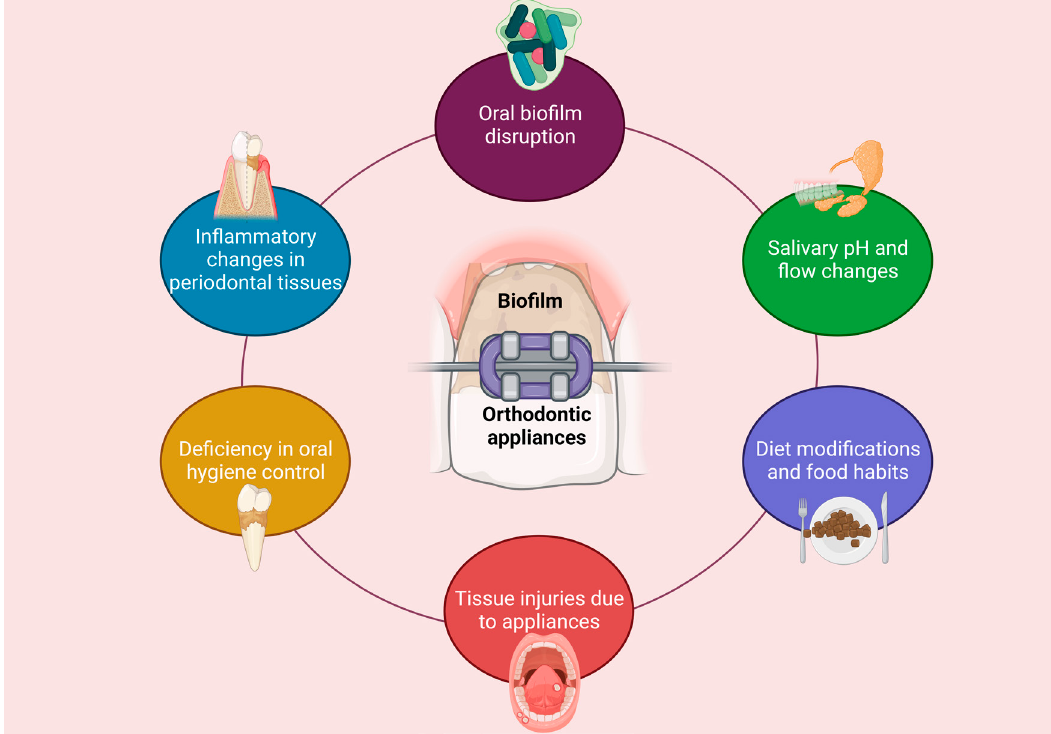
Figure 1. Orthodontic appliances impact oral health since patients must change their eating habits. Braces create oral hygiene difficulty and produce changes in salivary pH and disruption of the oral biofilm leading to inflammatory changes, plus damage to the periodontal